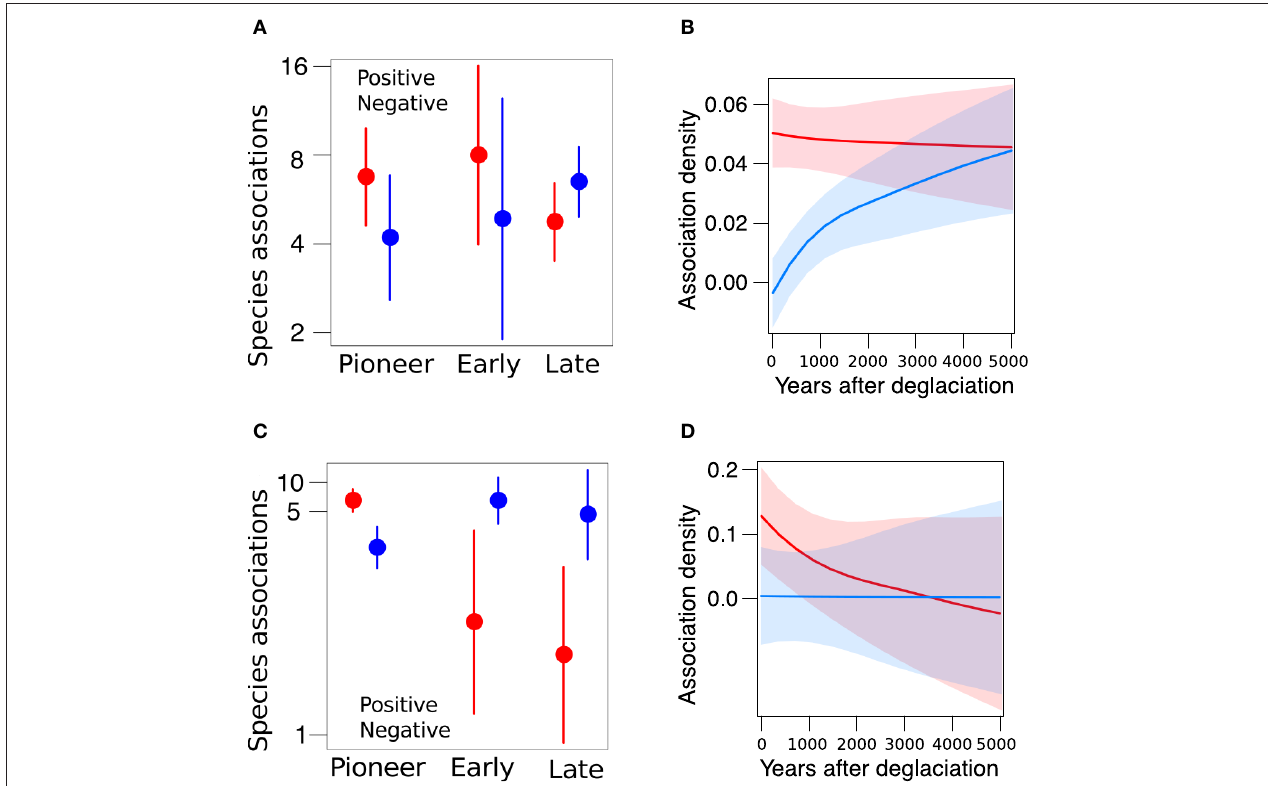
FIGURE 4 | Distribution of positive (red) and negative (blue) associations across species (A,C) and along the glacier foreland (B,D) in the Amola site (above) and Trobio site (below). Reported marginal means and 95% CI.